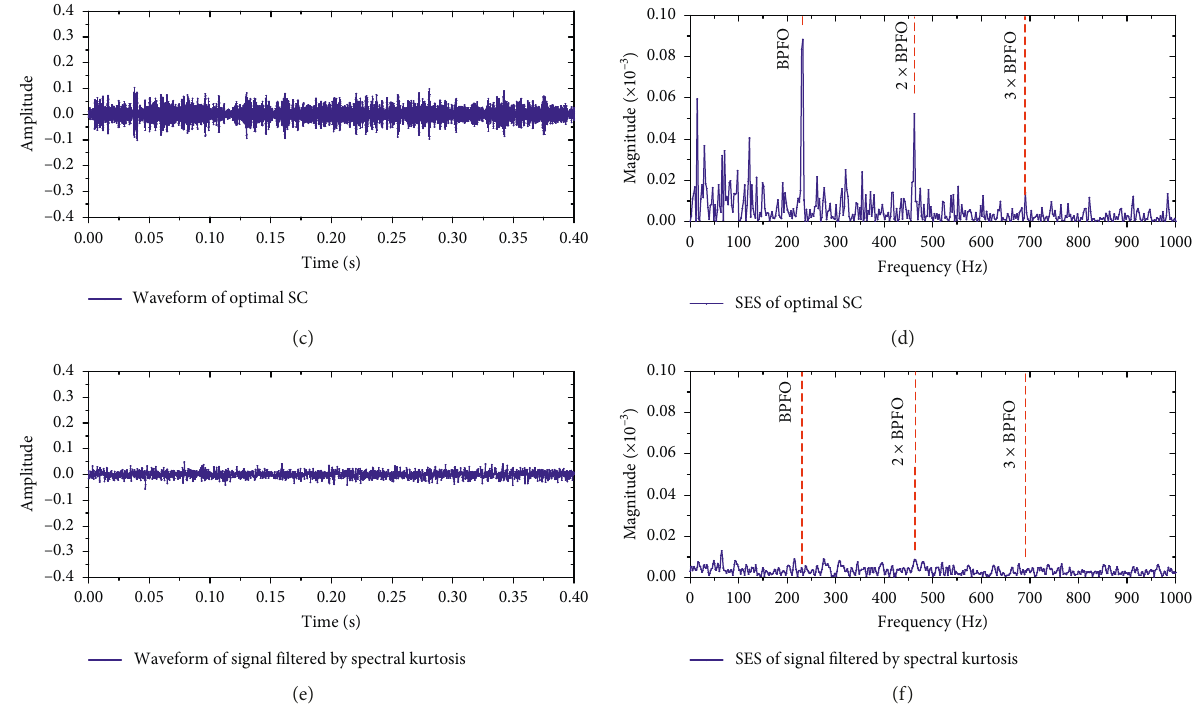
Figure 11: The results of the experiment: waveform at point 535 (a) and its squared envelope spectrum of incipient fault in point 535 (b); waveform of optimal SC (c) and its squared envelope spectrum (d); waveform of signal filtered by fast kurtogram (e) and its squared envelope spectrum (f).